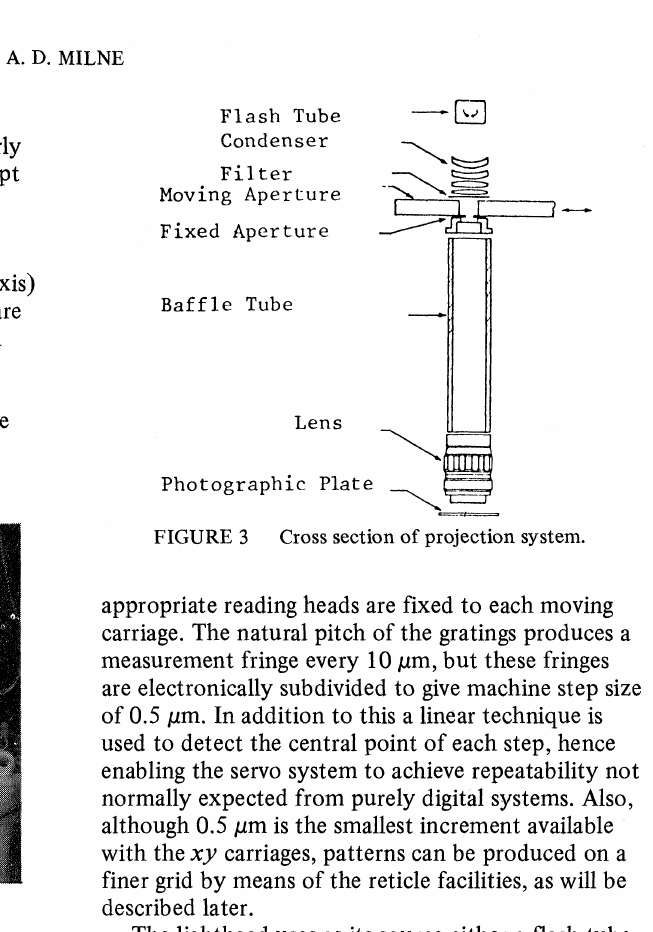
Pattern Generator (front).